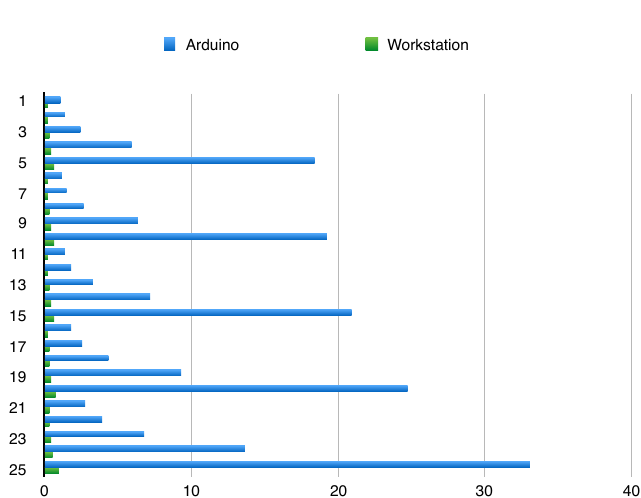
Figure 4. Comparison of execution